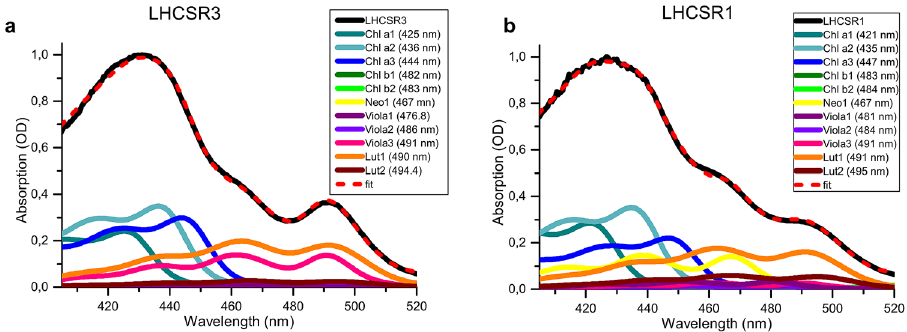
Figure 4. Deconvolution of LHCSR1 and LHCSR3 absorption spectra in the Soret region with chlorophyll and carotenoids spectral forms. Absorption spectra of reconstituted LHCSR3 ( a ) and LHCSR1 ( b ) in the Soret region is represented by the black solid lines. The absorption forms of the single pigments were used to fit the Soret region of the absorption spectra of the complexes accordingly to the constraints posed by different stoichiometry of pigments. Wavelength of the lowest energy absorption peaks in the Soret region are reported for each spectral form in brackets. Spectral deconvolutions of the absorption spectra are shown in red. Chl a/b chlorophyll a/b, Neo neoxanthin, Viola violaxanthin, Lut lutein. The figure was prepared by using OriginPro 2018 software https ://www.origi